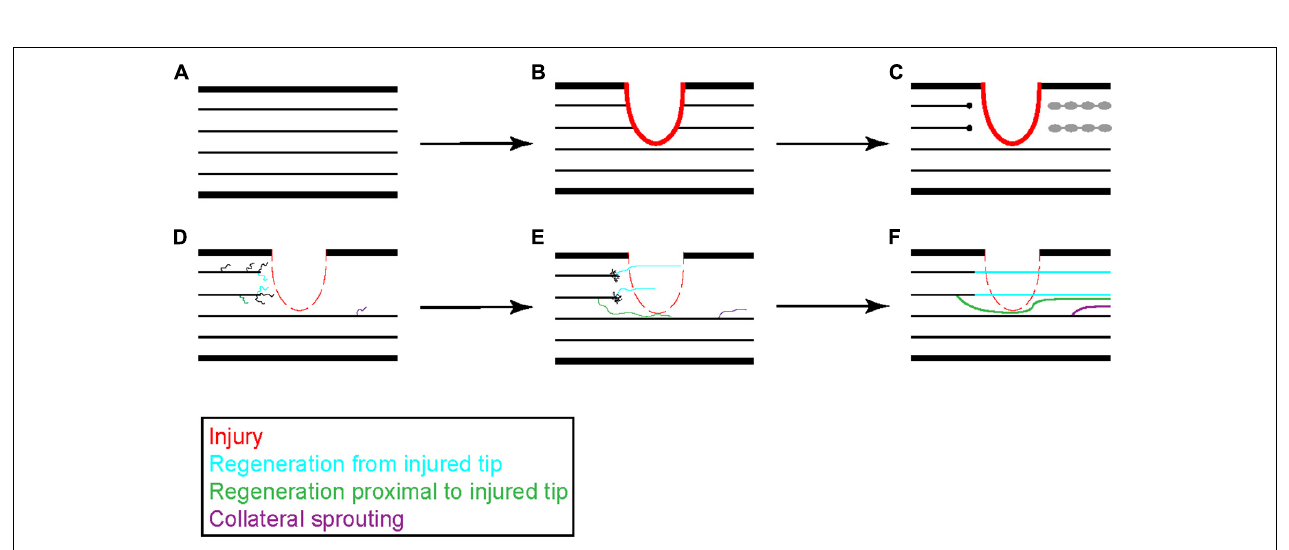
FIGURE 2 | Progression of peripheral axon regeneration following injury. Following peripheral nerve injury (A,B) , the distal portion of an injured peripheral axon undergoes Wallerian degeneration and is cleared by invading macrophages while the proximal end retracts a short distance from the site of injury (C) . The proximal end of the injured axon will stabilize and form a growth cone that generates new neurites to sample the surrounding environment. These neurites can originate from the injured tip, as shown in blue, or from the axon shaft, as shown in green. Surviving axons can also undergo collateral sprouting, shown in purple, to help reinnervate distal tissues (D) . Neurites that receive sufficient growth factor signaling stabilize and elongate while the others retract back to the main axon shaft (E) . Occasionally two neurites from a single damaged axon can stabilize leading to growth from two branches. These new growths can navigate through the injured tissue or around the injured tissue to reestablish pre-injury synaptic connections (F)